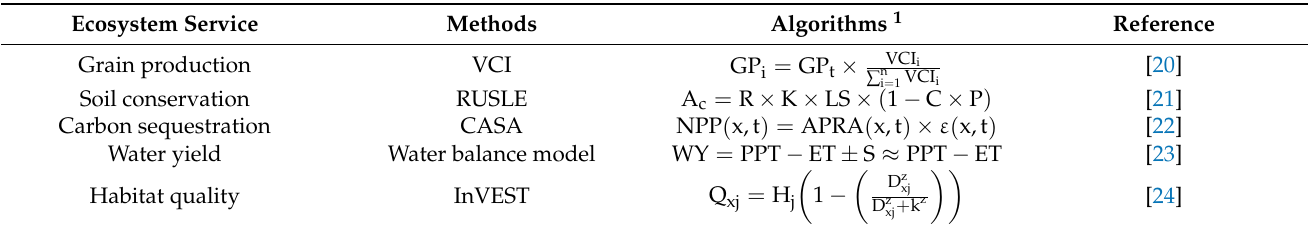
Table 2. The methods and main references to evaluate ecosystem